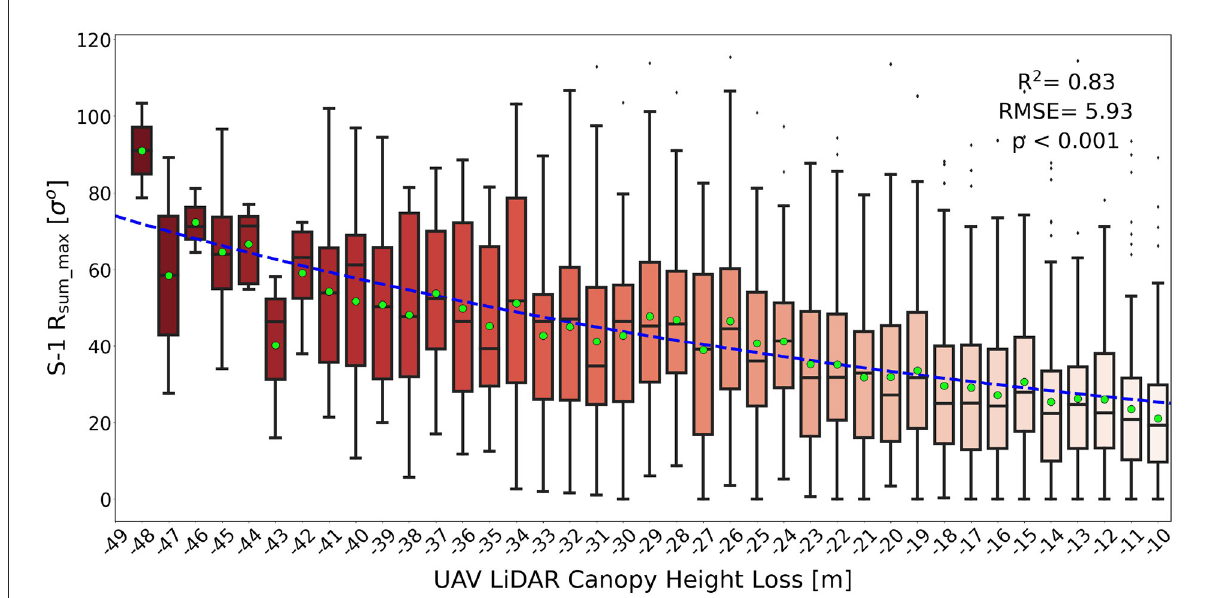
FIGURE8 Distribution (boxplots) and means (green circles) of Sentinel-1 CuSum maximum backscatter for each UAV LiDAR measurement of canopy height loss in our study area in Gabon. Data is binned into intervals of canopy height loss of 1 m. The mean values of the distribution follow an exponential decay curve (blue dashed line) in the form y = ae ( − bx ) , where a = 18.67 and b = 0.03. The coefficient of determination R 2 , the Root Mean Square Error (RMSE) and the p -value are shown on the plot.